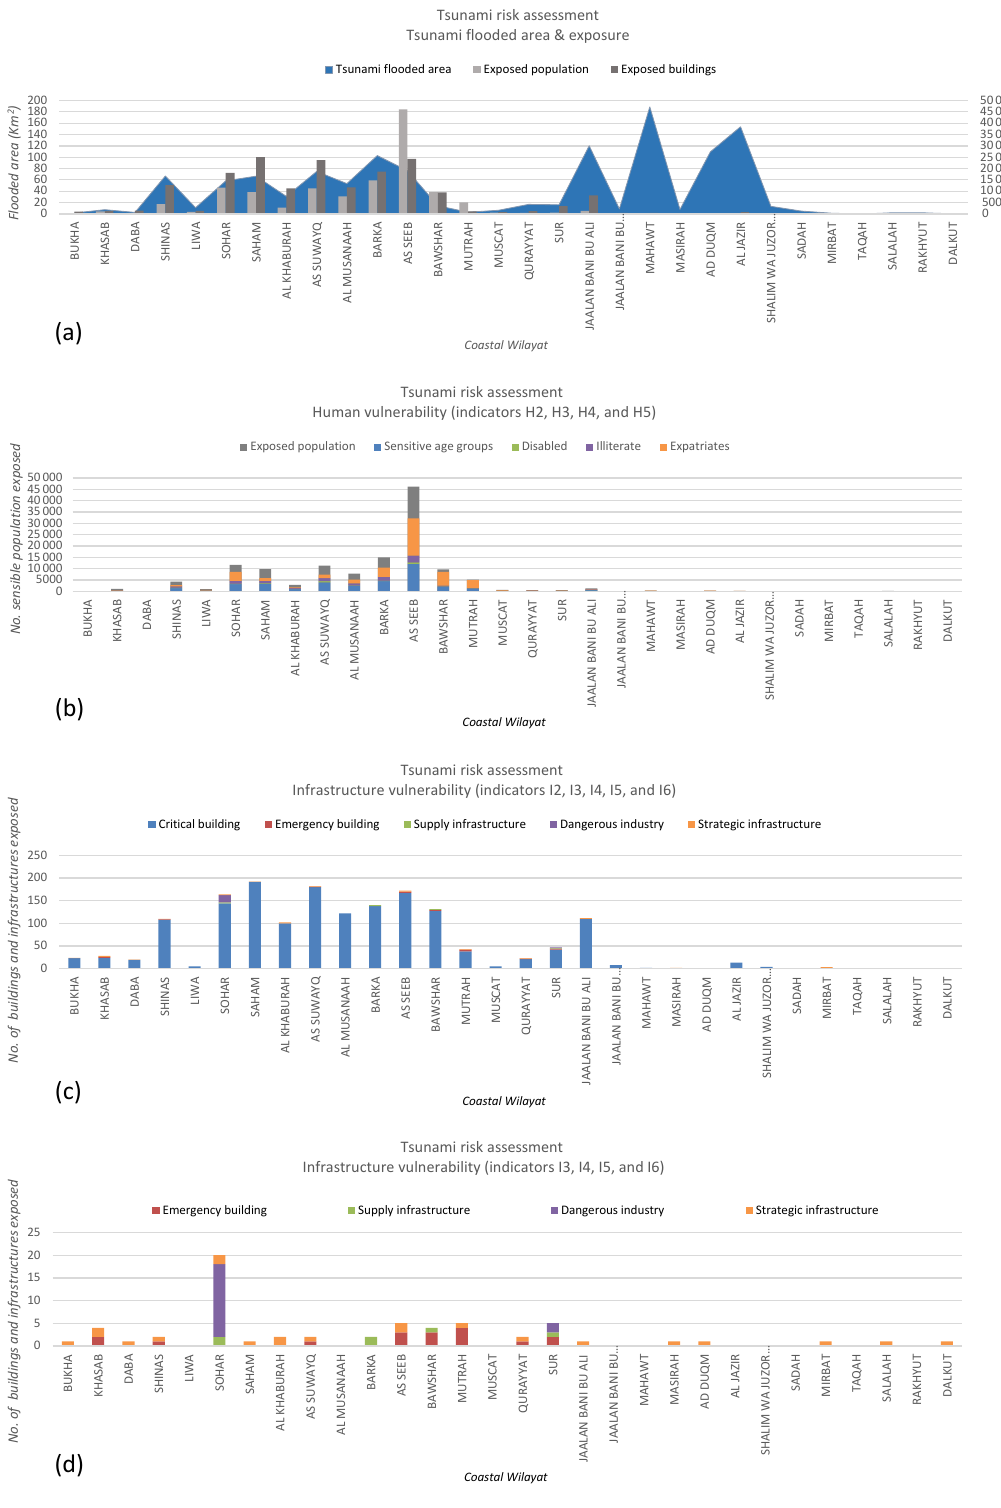
Figure 8. Tsunami risk assessment: (a) tsunami flooded area and exposure, (b) human exposure and vulnerability variables, (c, d) infrastruc- ture exposure and vulnerability